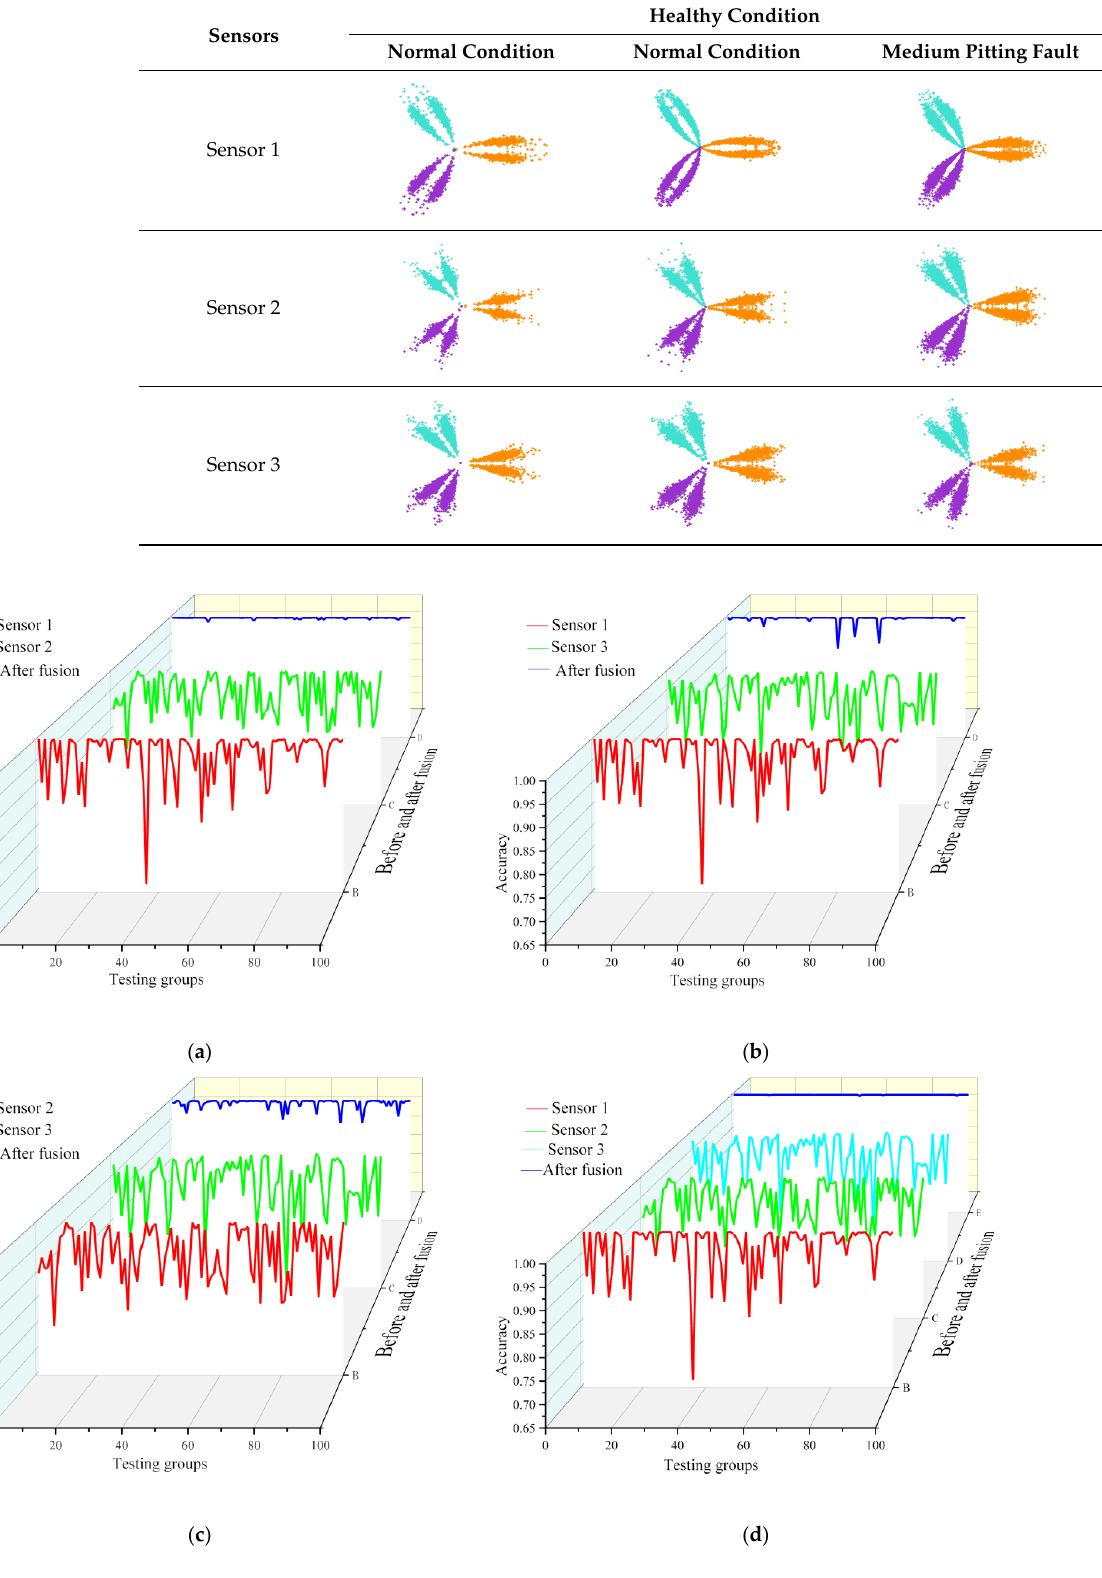
Figure 14. Before and after the fusion of multiple sensors. ( a ) Sensor 1 and sensor 2 fusion. ( b ) Sensor 1 and sensor 3 fusion. ( c ) Sensor 2 and sensor 3 fusion. ( d ) Fusion of all three sensors.